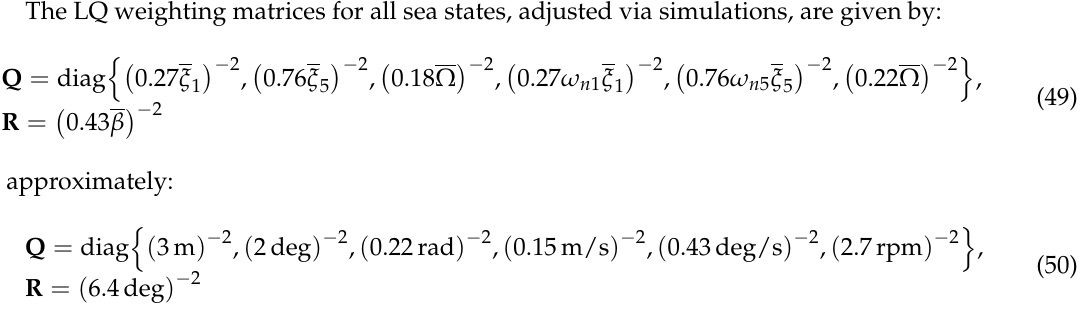
Figure 5. LQ control of a spar FOWT—rough sea state.